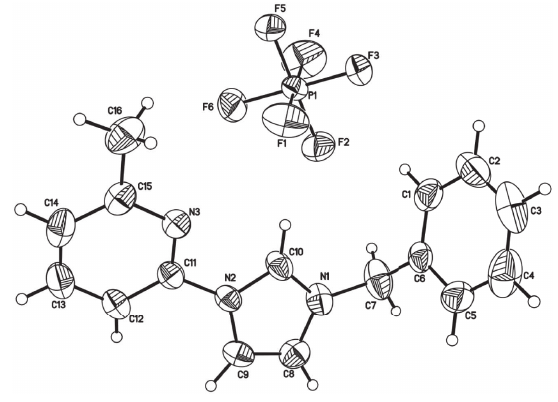
Table 1: Data collection and handling.